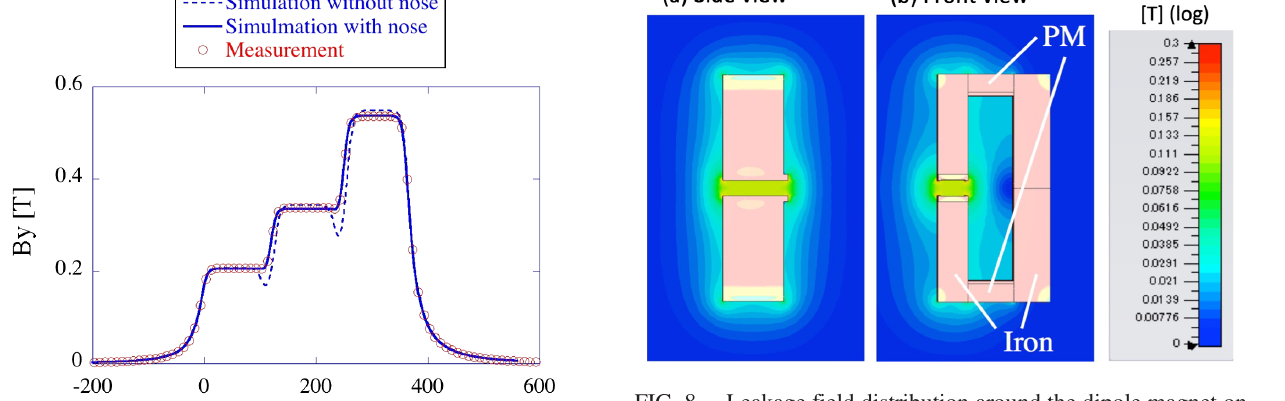
FIG. 8. Leakage field distribution around the dipole magnet on a log scale. High leakage areas are shown in red, while low leakage areas are in blue. PM stands for permanent